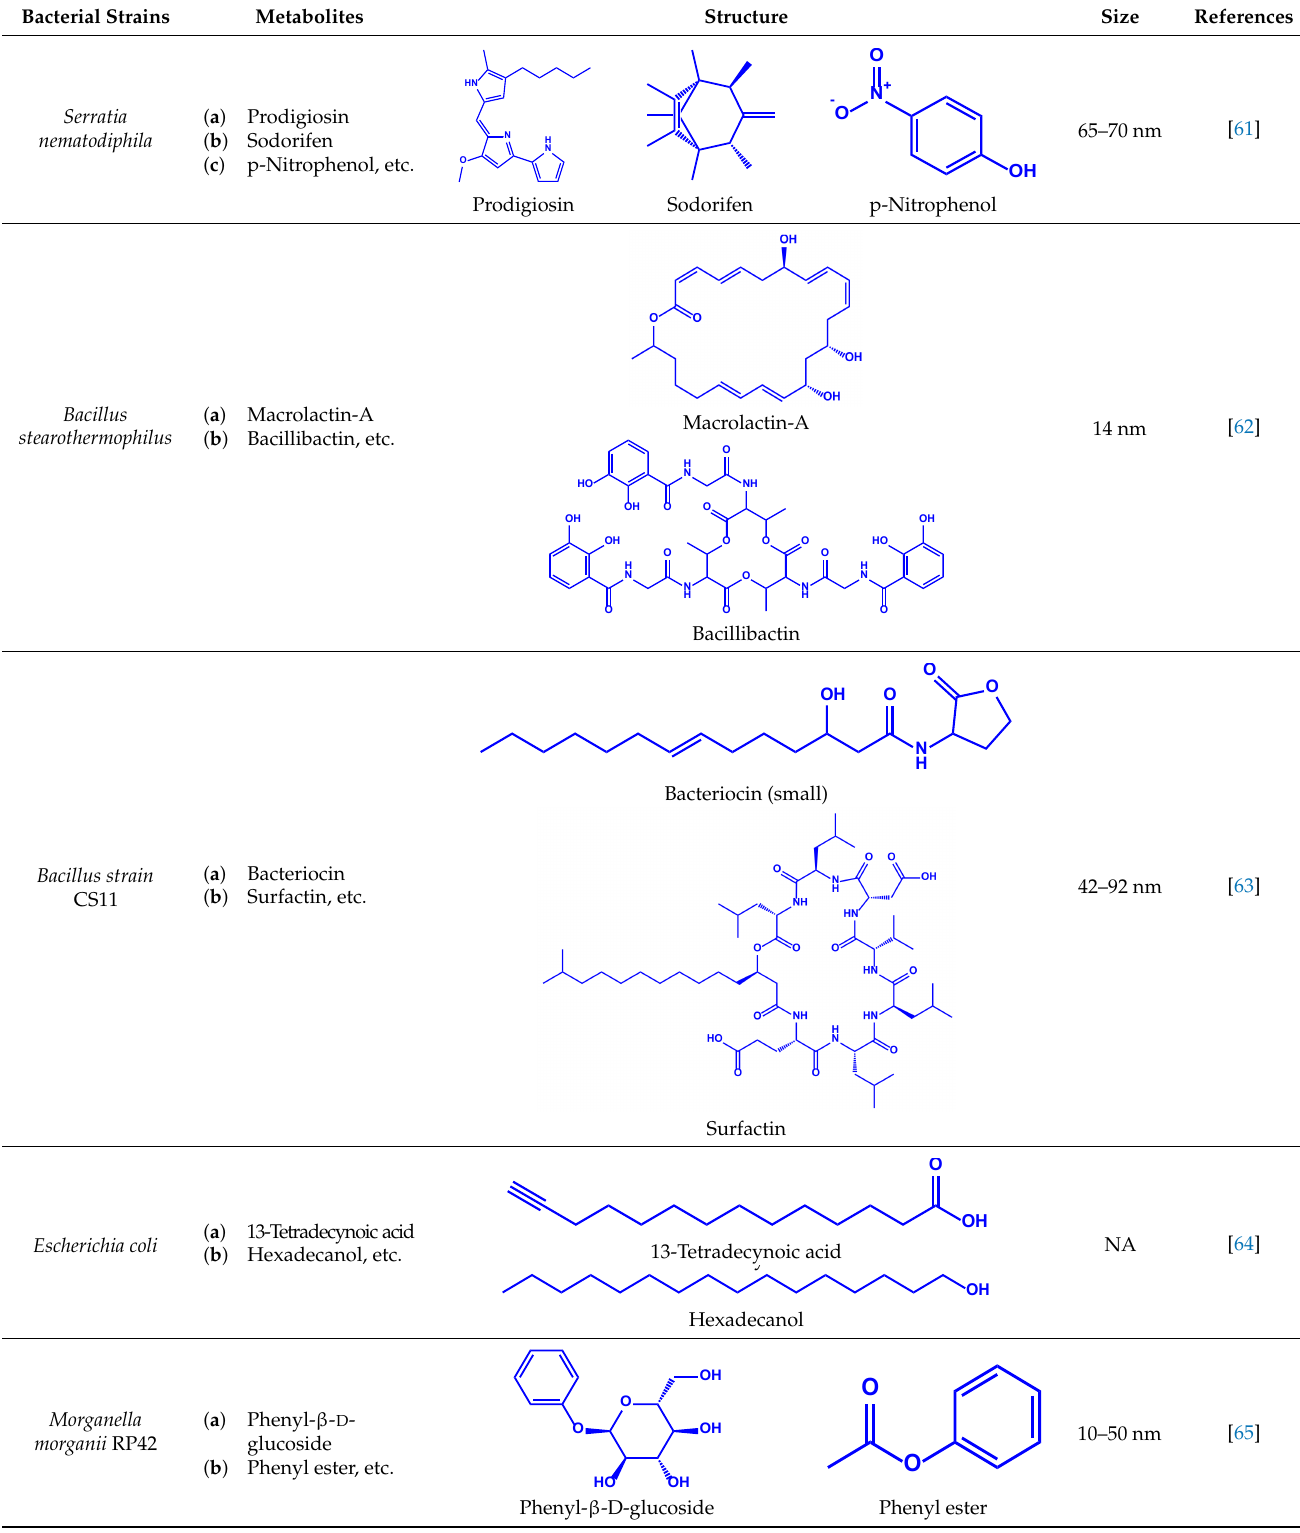
Table 2. Biological synthesis of AgNPs by various bacterial strains.